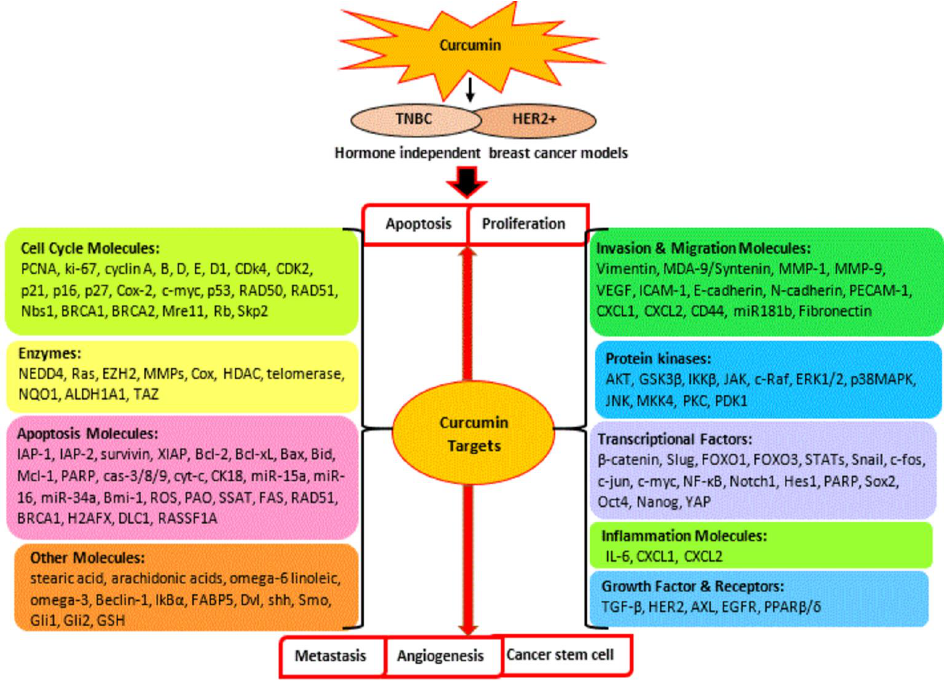
Figure 7. Multi-target action of curcumin against TNBC and hormone-independent HER2 positive breast cancer. Curcumin induces apoptotic cell death and suppresses cellular growth, proliferation, metastasis, angiogenesis, and cancer stem cell through the regulation of multiple molecular targets.